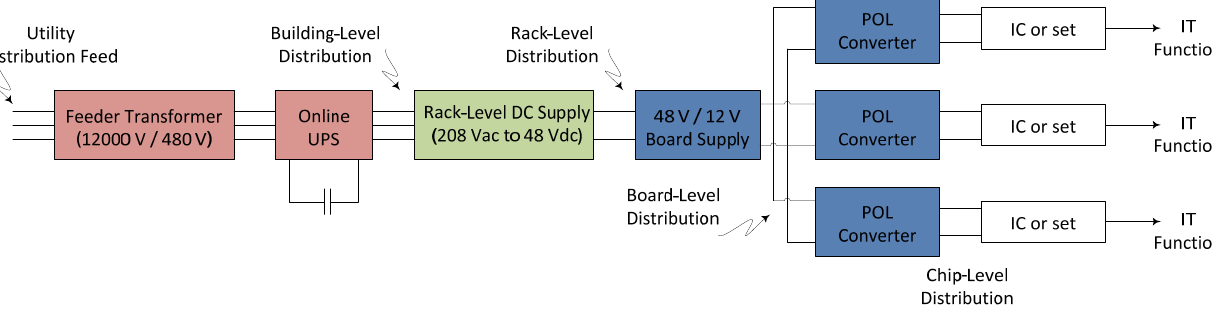
Figure 1. Typical AC data center layout emphasizing power distribution voltage levels [13].